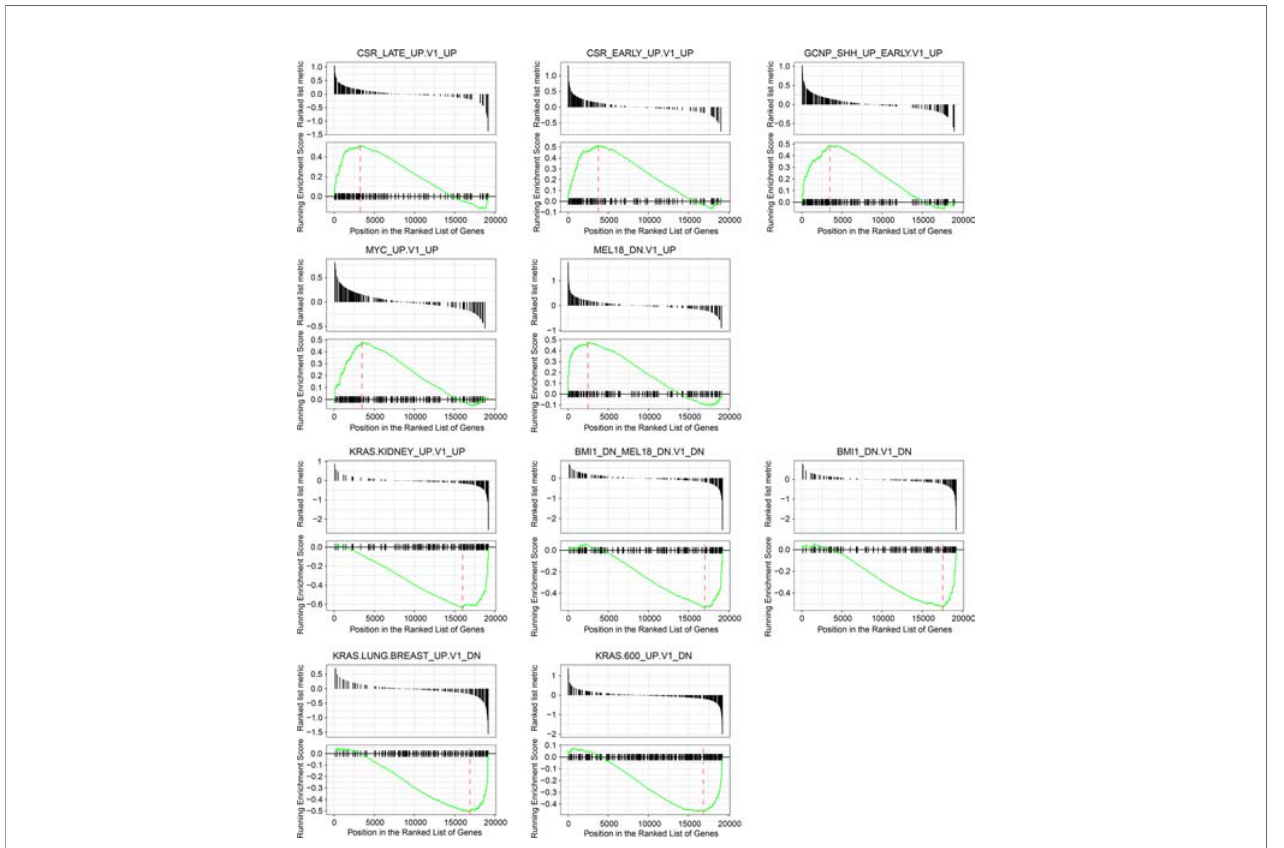
FIGURE 7 | Gene set enrichment analysis based on SPIB expression. Among signi fi cantly enriched gene sets, top fi ve up-regulated and down-regulated ones and their corresponding enrichment plots were